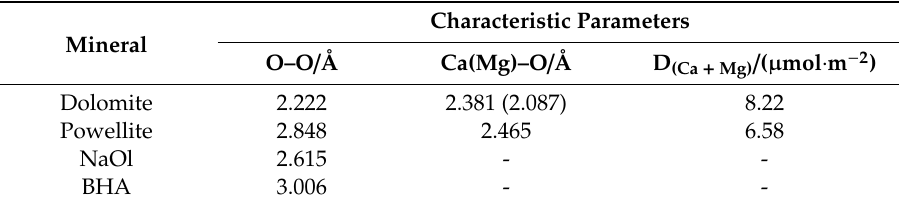
Figure 8. The optimized unit cell of dolomite and powellite with labeled O–O distance and Ca–O bond length (gray, C; red, O; blue, N; green, Ca; green-yellow, Mg; and cyan, Mo). Table 3. Crystal and structure chemical parameters of minerals and reagents.